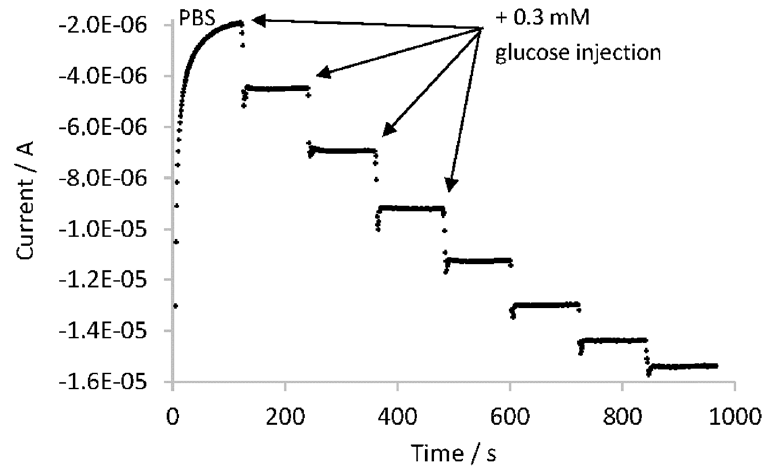
Figure 4. Current-time plot of Chitosan–GOx/TiO 2 NTAs/Ti biosensor with applied potential of − 0.4 V when 0.3 mM glucose injections were done.